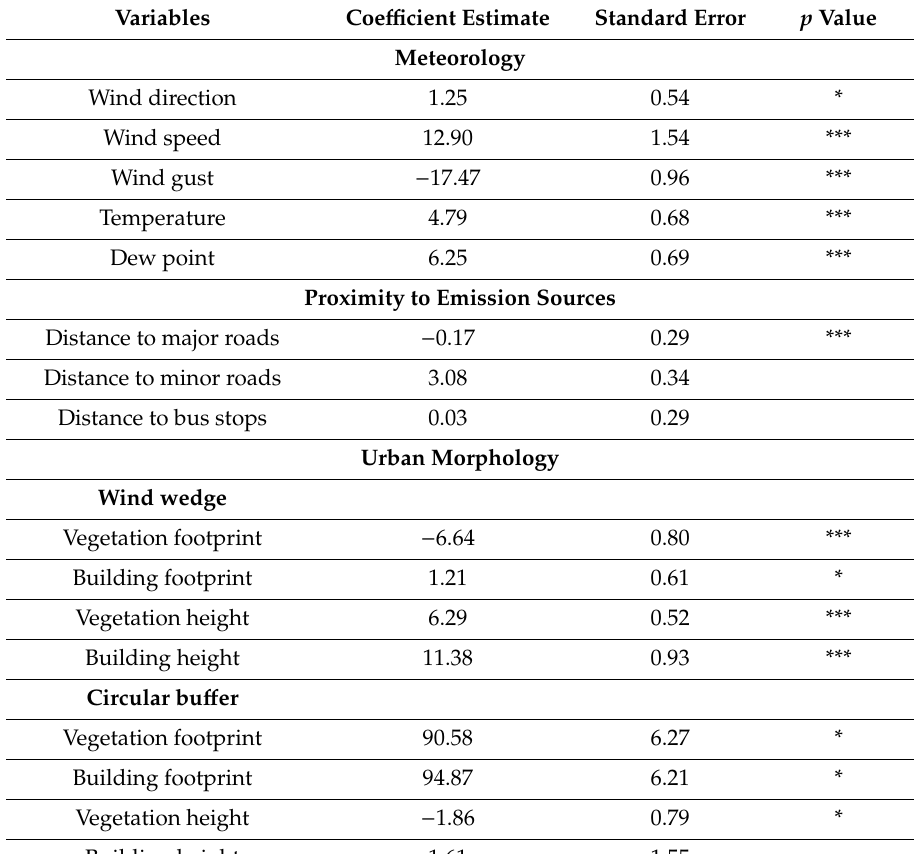
Table 2. Results of fixed e ff ects panel